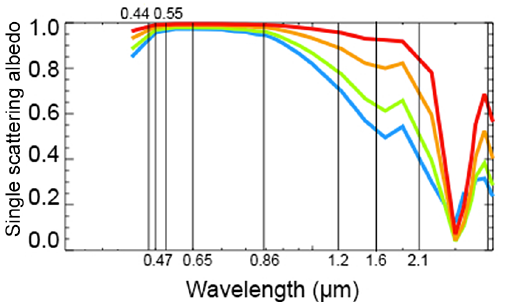
Figure 9. OPAC single scattering albedo as a function of humidity (color) and wavelength. The various relative humidity levels are in order (red, orange, green, and blue) for 95, 80, 30, and 0% column relative humidity.